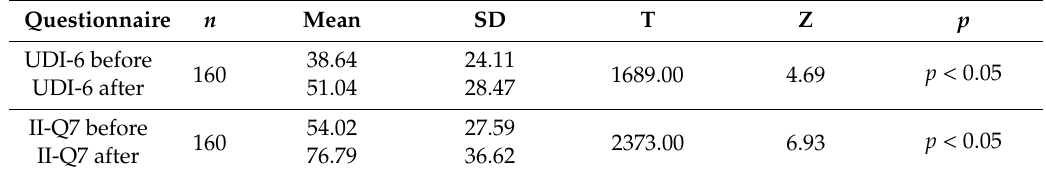
Table 5. Impact of oncological treatment on the prevalence of urinary incontinence symptoms and impact on patients’ everyday life (UDI-6 and II-Q7 questionnaires) (Wilcoxon’s signed-rank test).